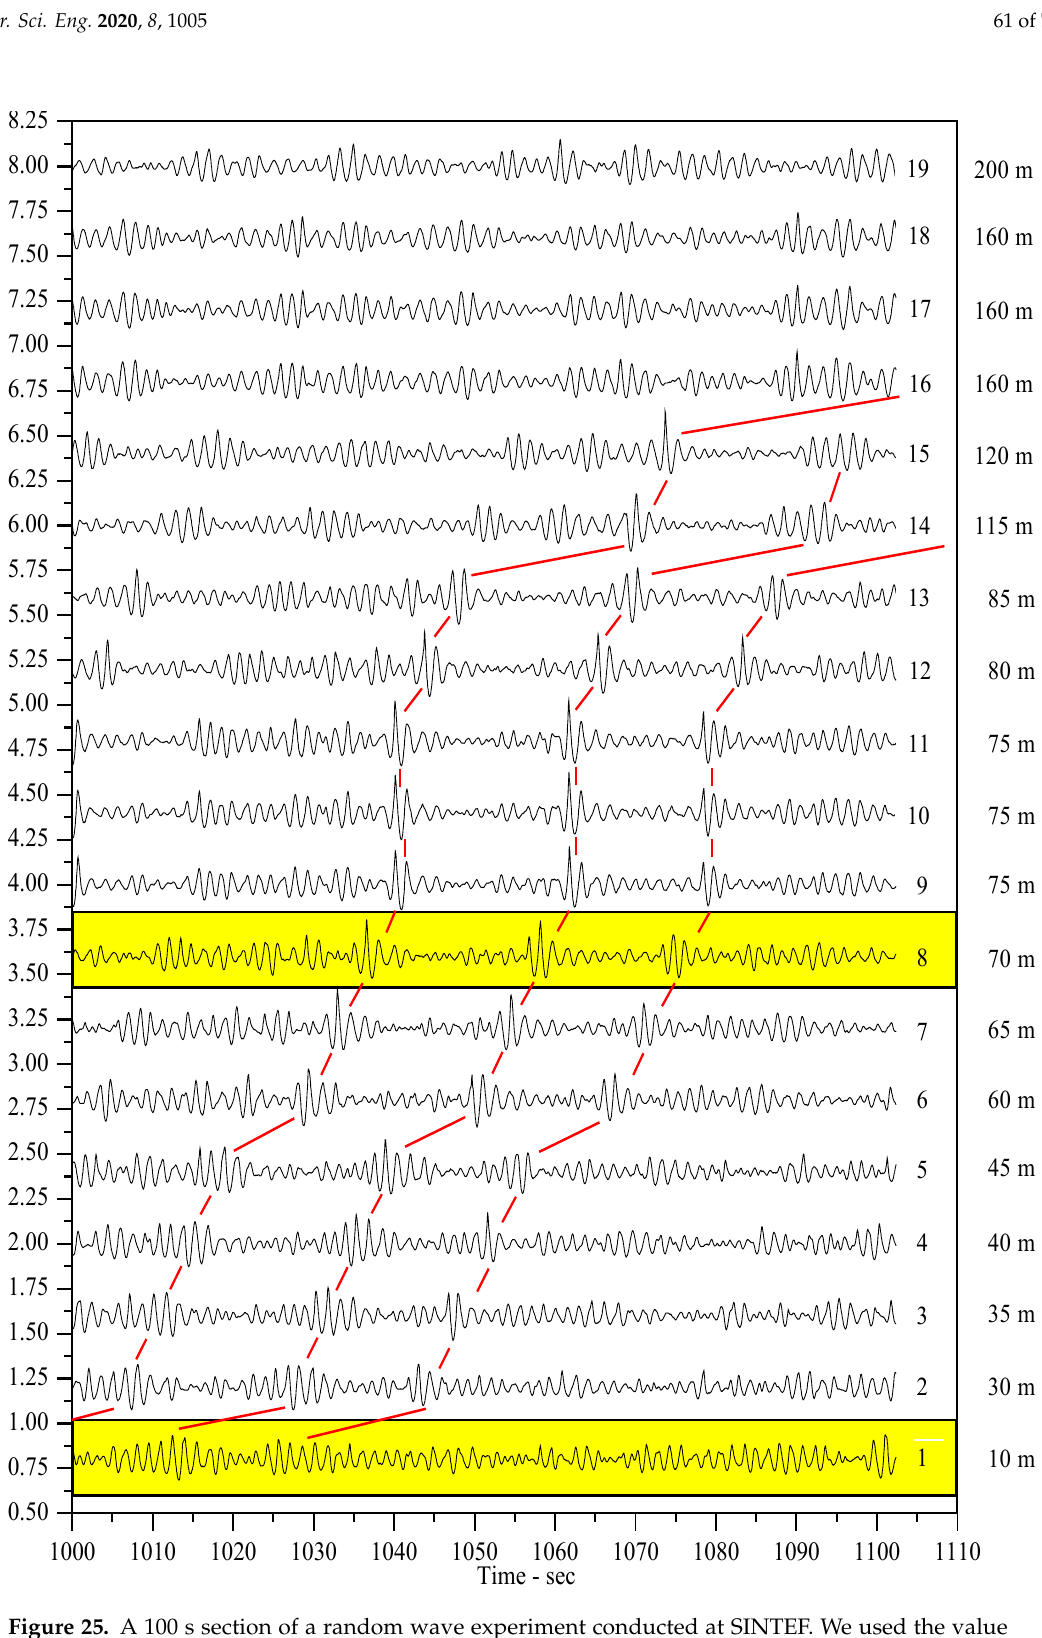
Figure 25. A 100 s section of a random wave experiment conducted at SINTEF. We used the value γ = 6 for the JONSWAP power spectrum. A total of 19 probes were placed along the tank, see probe numbers and distances down the right-hand side of the figure. The probe at 10 m has long and low packets corresponding to a high and narrow JONSWAP spectrum. Self-focusing occurs at later probes, leading to the formation of breather packets.